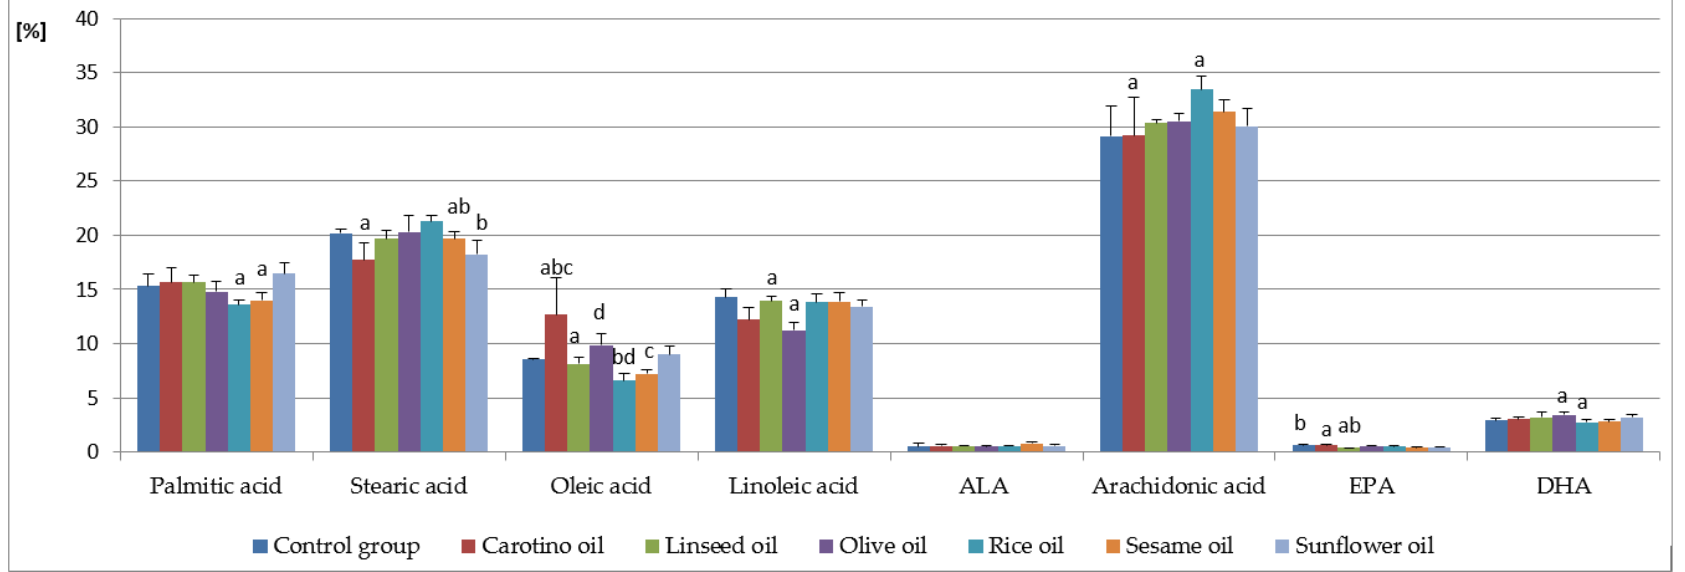
Figure 1. Contents of selected fatty acids in serum of rats supplemented with selected oils (%). Data were expressed as mean values ± standard deviation. Bars with the same superscript (a, b, c, or d) above referring to one fatty acid are significantly different in one-way ANOVA followed by RIR Tukey’s post-hoc test ( p < 0.05).